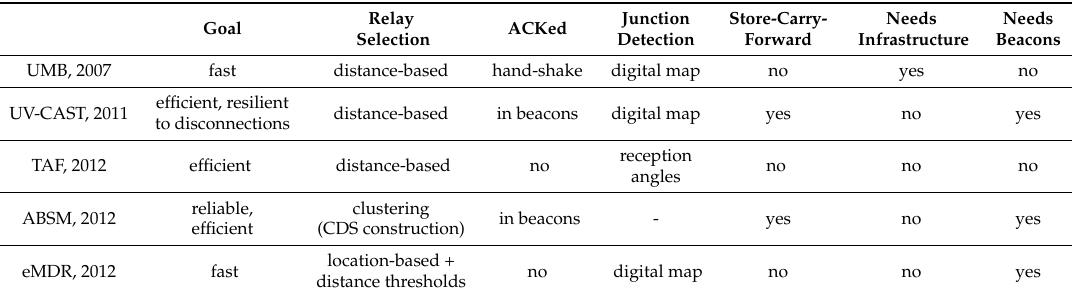
Table 1. Summary of the main works for urban dissemination. UMB, Urban Multihop Broadcast; UV-CAST, Urban Vehicular Broadcast; TAF, Two Angles Forwarding; ABSM, Acknowledged Broadcast from Static to Highly Mobile; CDS, connected dominating sets; eMDR, Enhanced Message Dissemination Based on